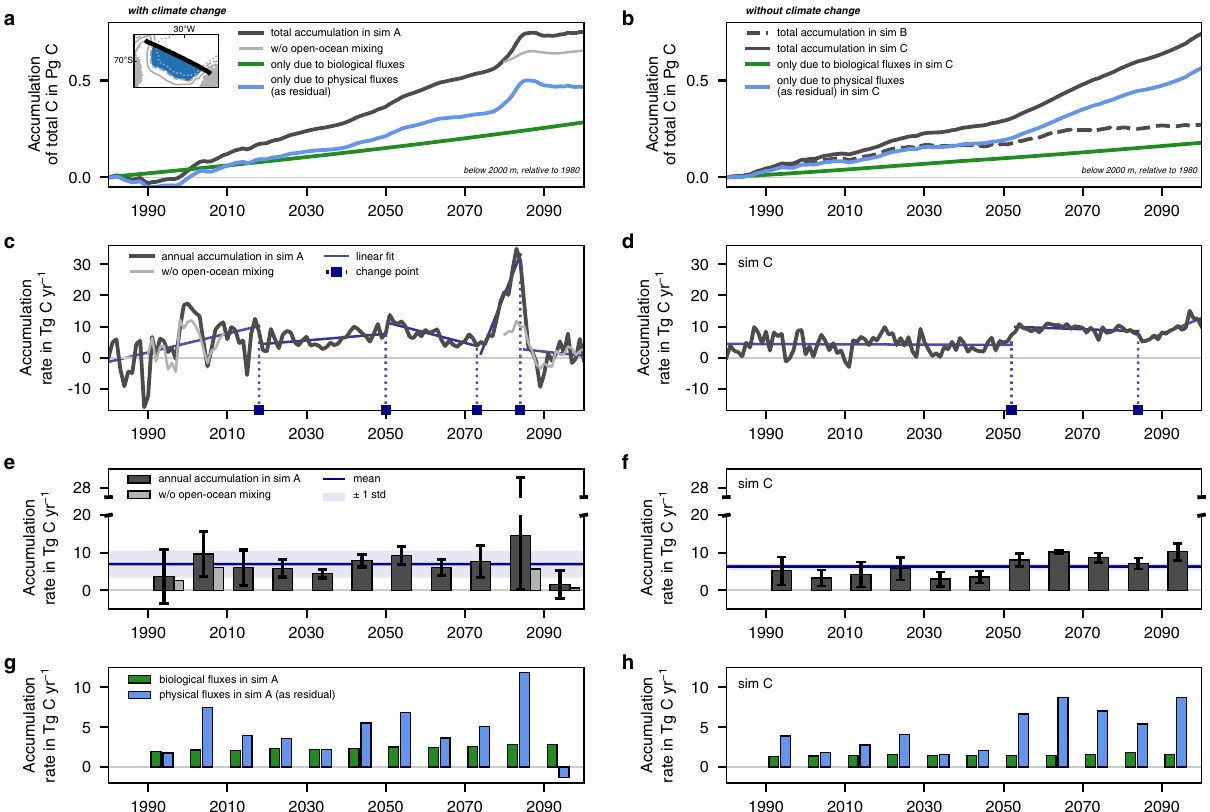
Fig. 2 Deep-ocean carbon accumulation. a , b Accumulated carbon in Pg C between 1980 and 2100 below 2000 m in the southern Weddell Sea south of the transect SR4 (see blue area in inlet) in a the model simulation simA (dark grey; historical + SSP5-8.5 scenario) and b the control simulation simB (dashed dark grey) and simC (solid dark grey; constant climate + varying atmospheric CO 2 ). c – f Show carbon accumulation rates in Tg C yr − 1 averaged c , d annually and e , f for each decade in c , e simA and d , f simC . In c , d , the dark blue lines indicate the statistical models providing the best fi ts to describe the time series, and change points are indicated with vertical lines and as squares on the x axis (see Methods and refs. 62,63 ). In e , f , the whiskers depict one standard deviation within each decade, the horizontal blue line indicates the average accumulation rate between 1990 – 2100, and the shading shows ± one standard deviation around the mean. The light grey lines in a , c and the light grey bars in e denote the accumulated carbon due to all processes except vertical mixing in the open ocean north of the 3500 m isobath (dotted line in the map in a ). The contribution of biological and physical fl uxes (the latter calculated as residual) in a , g simA and b , h simC are shown in green and blue, respectively. Biological fl uxes are dominated by sinking particle fl uxes (Supplementary Fig.